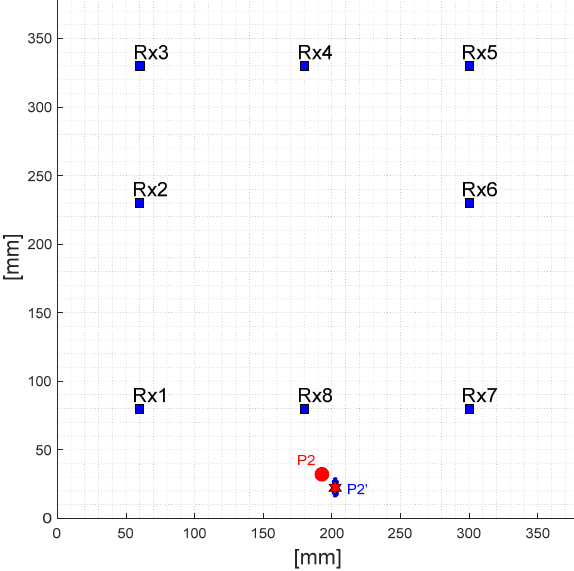
Figure 12. Position of impact P2 (red circle) outside the ROI. The detected impact position P2 ′ (red star) with coordinates x p = 202 mm, y p = 22 mm was obtained by processing signals acquired by all sensors. Reproduced from [24].